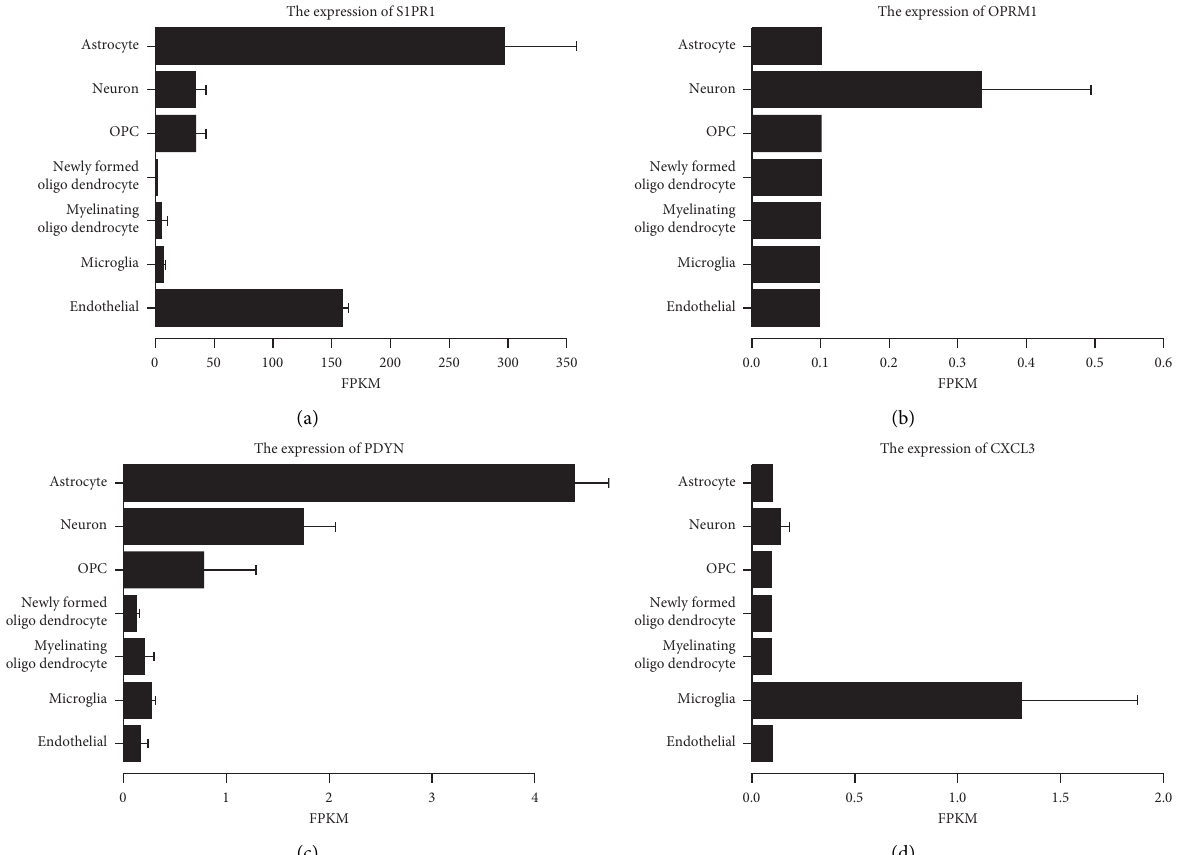
Figure 6: The hub gene expression and localization in brain cells. (a) S1PR1, (b) OPRM1, (c) PDYN, and (d)